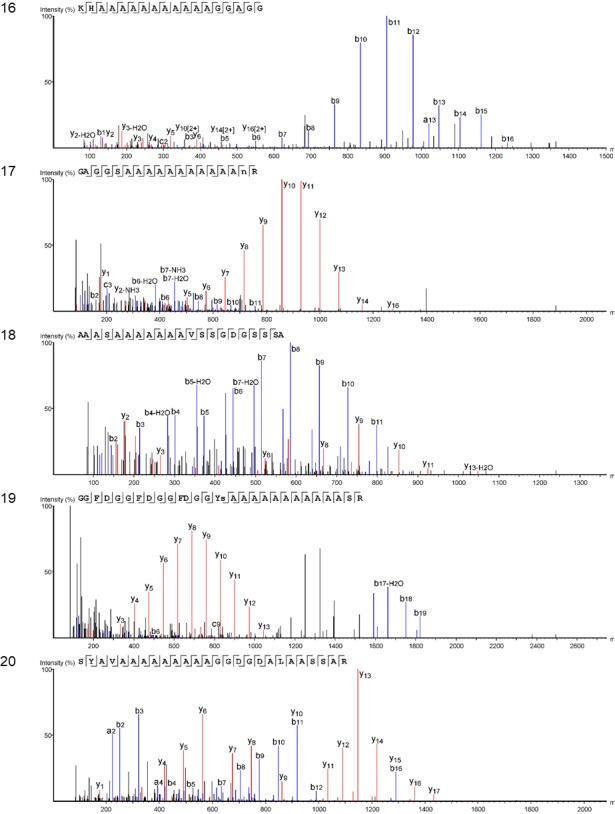
Product ion spectra [16 - 20] supporting the coverage of protein Hic74 identified in Unio pictorum.